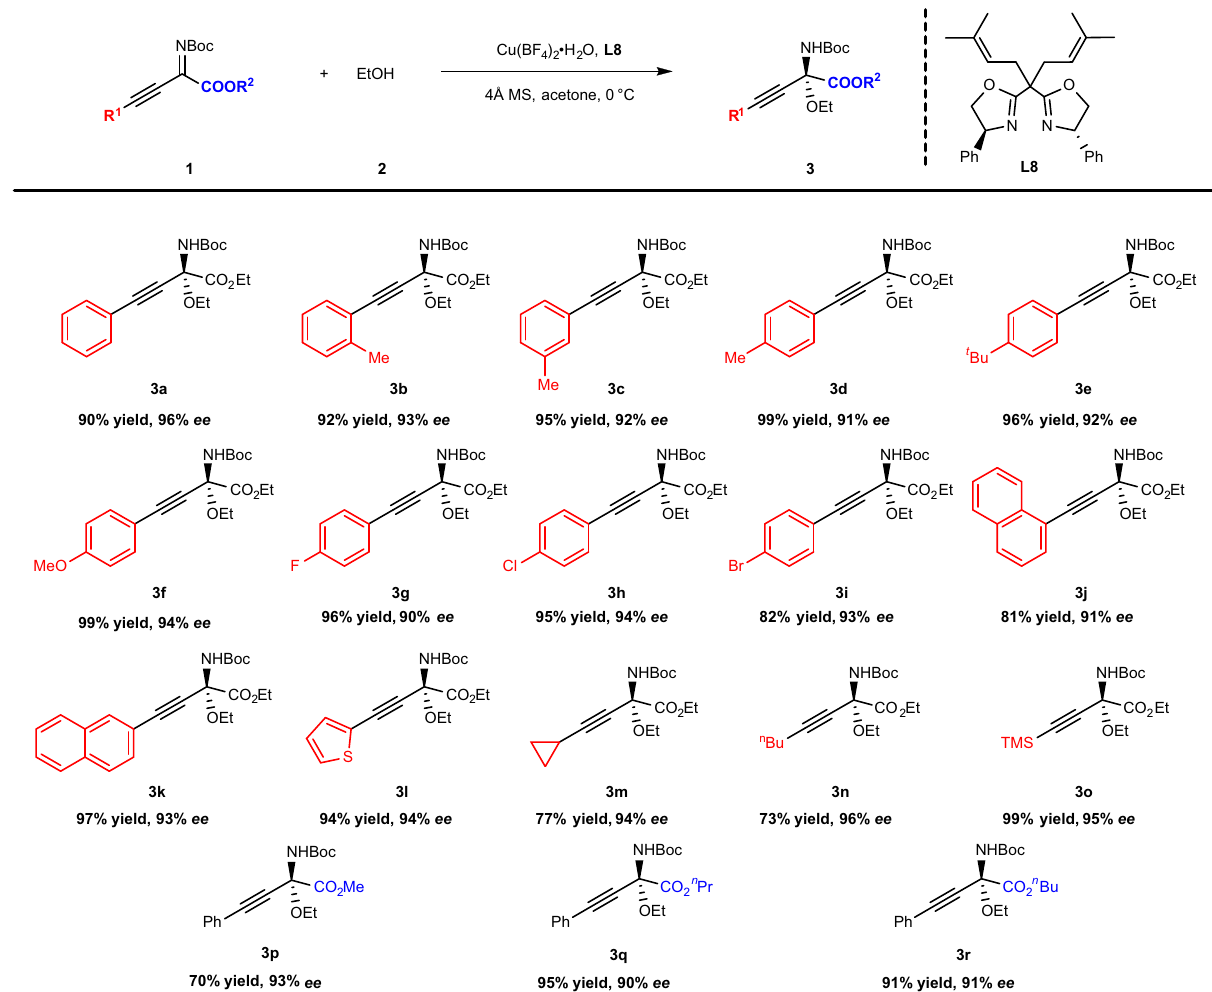
Fig. 3 Scope of β , γ -alkynyl- α -imino esters. Reaction conditions: 1 (0.10mmol), 2a (0.20 mmol), Cu(BF 4 ) 2 ∙ H 2 O (10 mol%), L8 (15 mol%), 4 Å MS (40 mg), acetone (1.0 ml), 0 °C, 24 h; the yield refers to isolated yield; the ee value was determined by